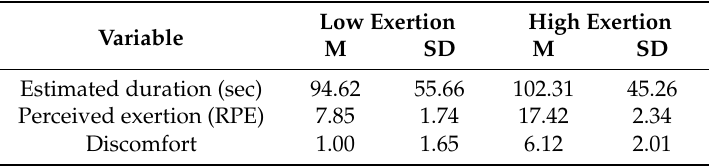
Table 4. Means and Standard Deviations of Estimated Duration, Perceived Exertion, and Discomfort under Conditions of Low Exertion and High Exertion in Experiment